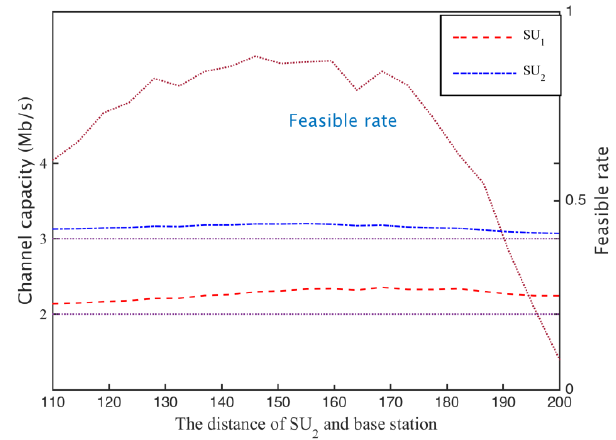
Figure 17. Each secondary user’s channel capacity.